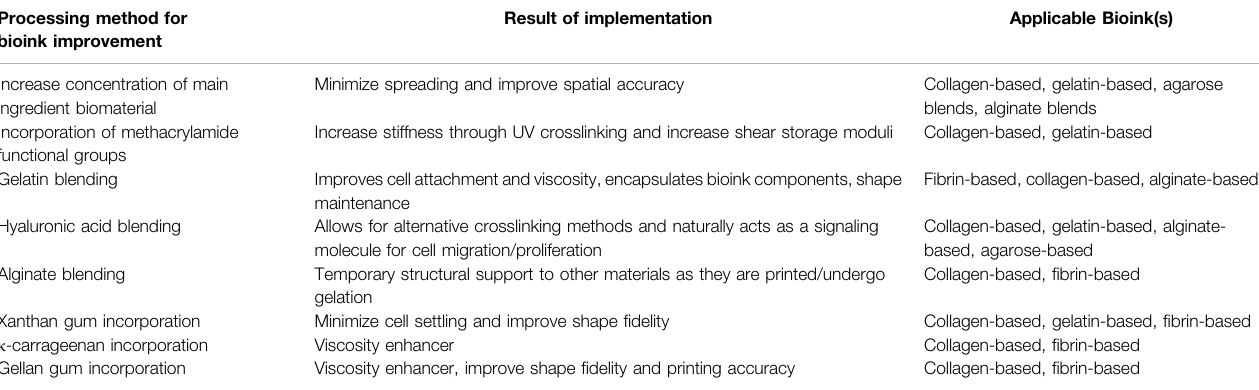
TABLE 2 | Bioink processing and formulation methods that affect overall